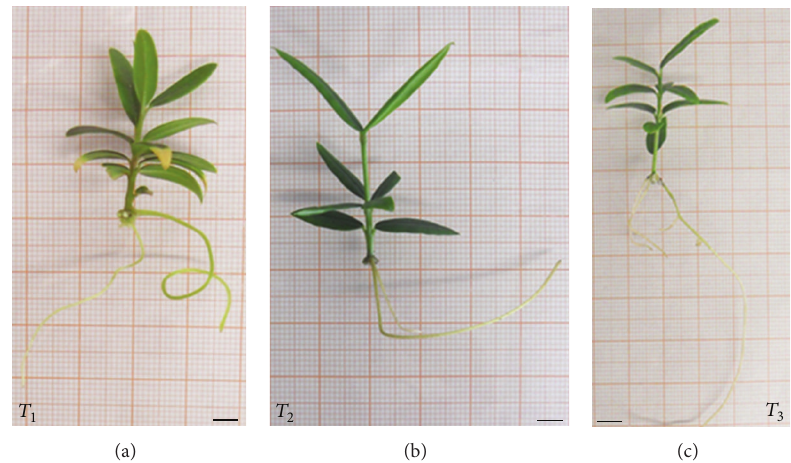
Figure 3: Effect of different IBA concentration on adventitious root morphology of Olea europaea subsp. europaea var. sylvestris grown on different medium. 𝑇 1 : OR medium without IBA; 𝑇 2 : short pretreatment with 14.7 mM IBA sterile solution and inoculation into the OR medium supplemented with 0.5 mg/L IBA; 𝑇 3 : short pretreatment with 14.7 mM IBA sterile solution and inoculation into the OR medium supplemented with 1mg/L IBA. (a) = 1.9 mm; (b) = 1.3 mm; (c) = 1.9